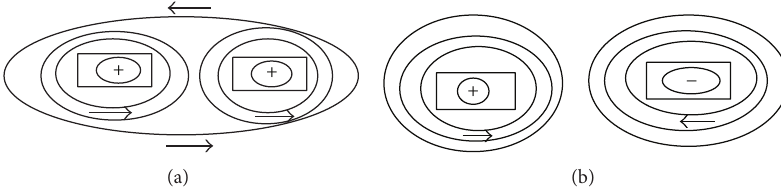
Figure 4: (a) Positive mutual coupling and (b) out-of-phase